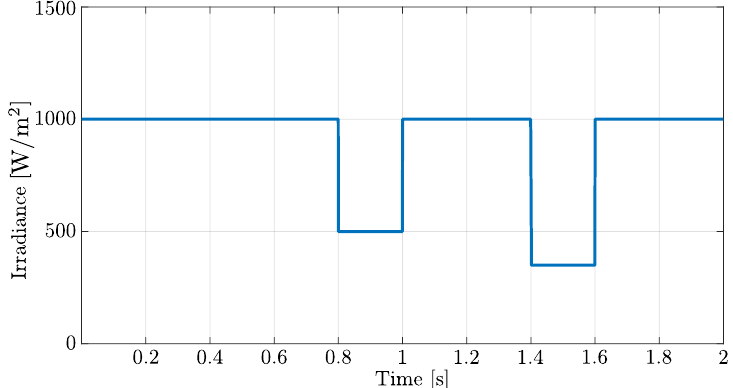
Figure 10. Irradiance profile for the PV array.